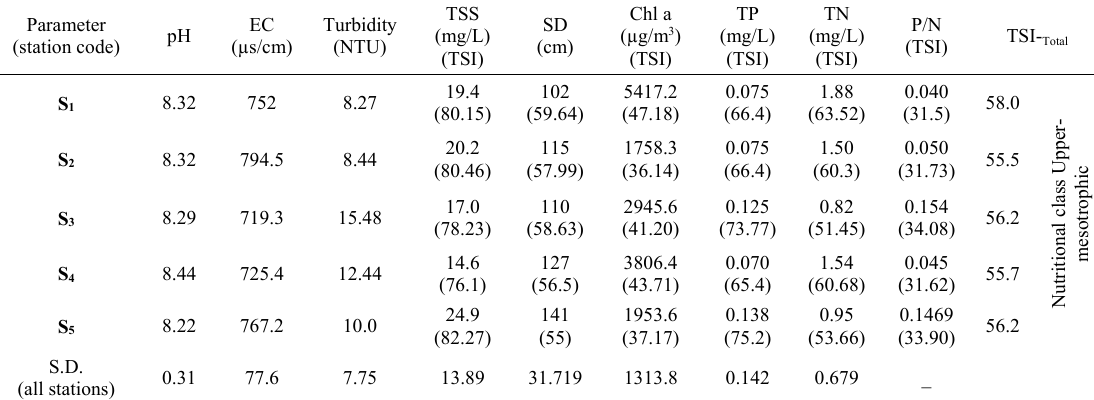
Table 2: Water quality parameters and calculated eutrophication index in the stations